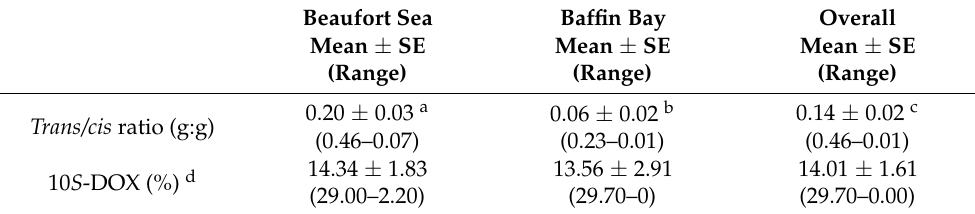
Table 1. Percentage of 10 S -DOX degradation of palmitoleic acid and trans/cis ratio of vaccenic acid observed in sediment samples collected in the Canadian Arctic during the ArcticNet, Malina, and GreenEdge expeditions. Beaufort Sea Mean ± SE